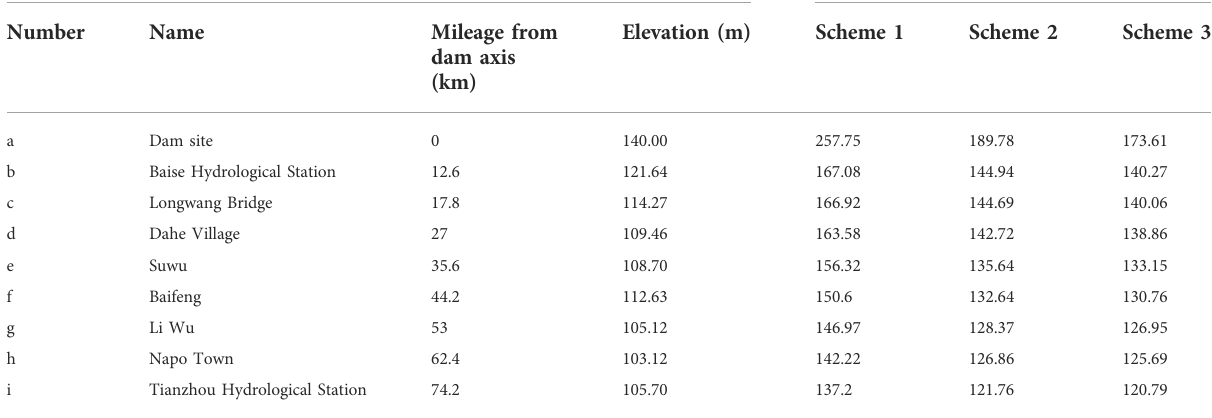
TABLE 6 Maximum water level change along the dam